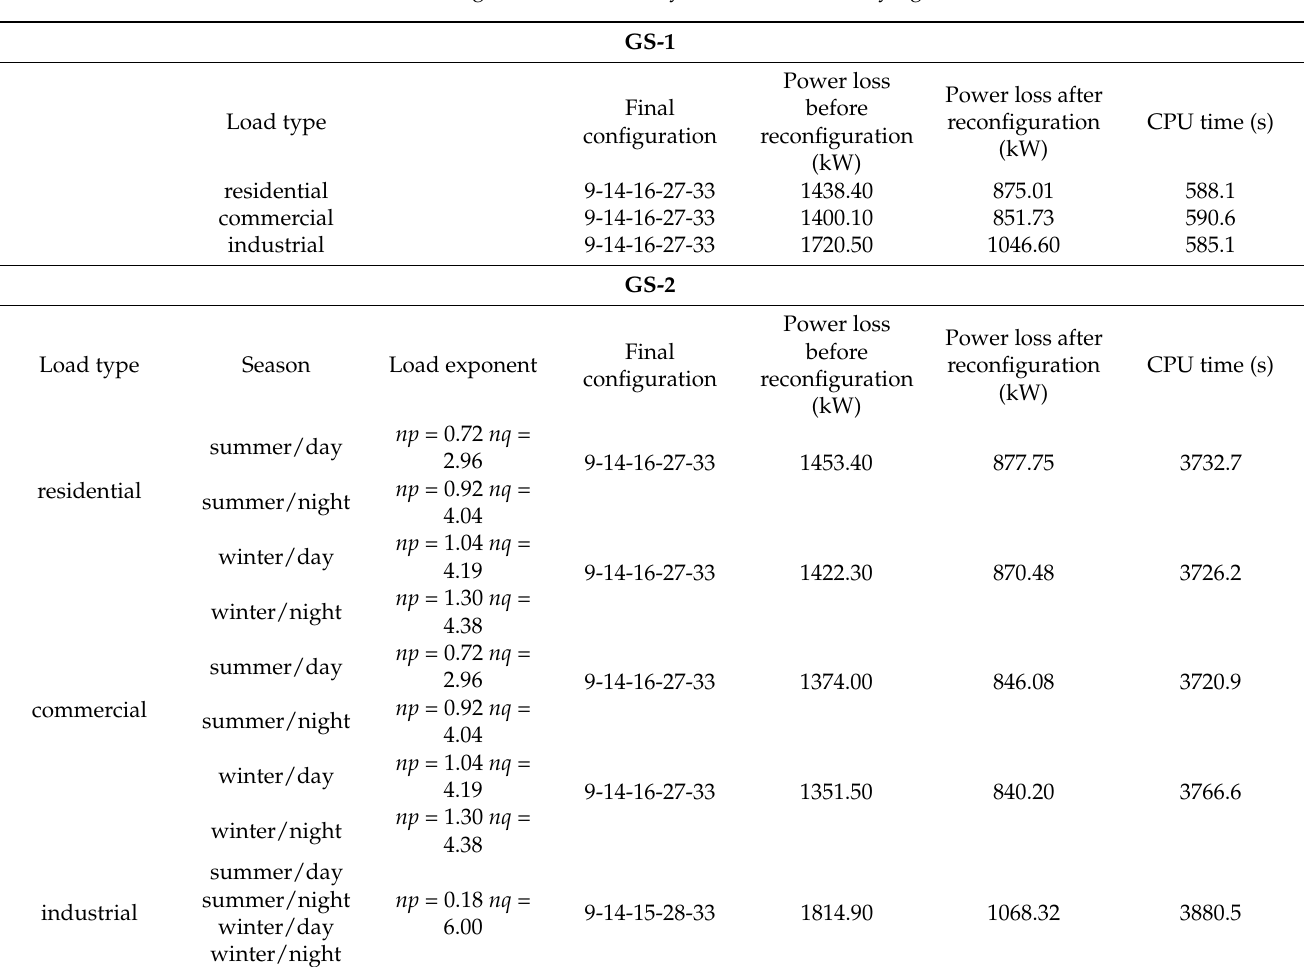
Table 4. Reconfiguration results of systems with time varying